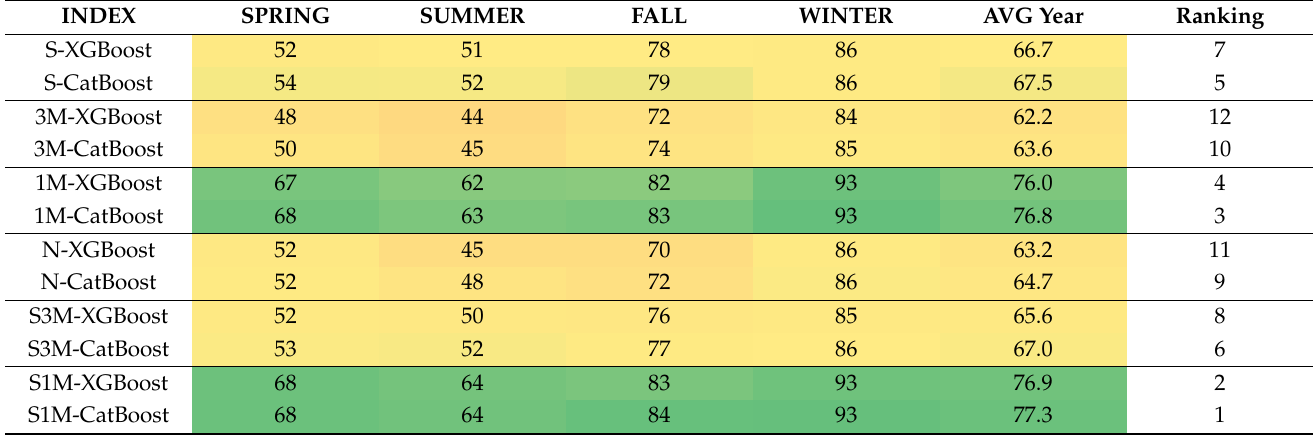
Table 2. Average skill score RMSE (%) per season per